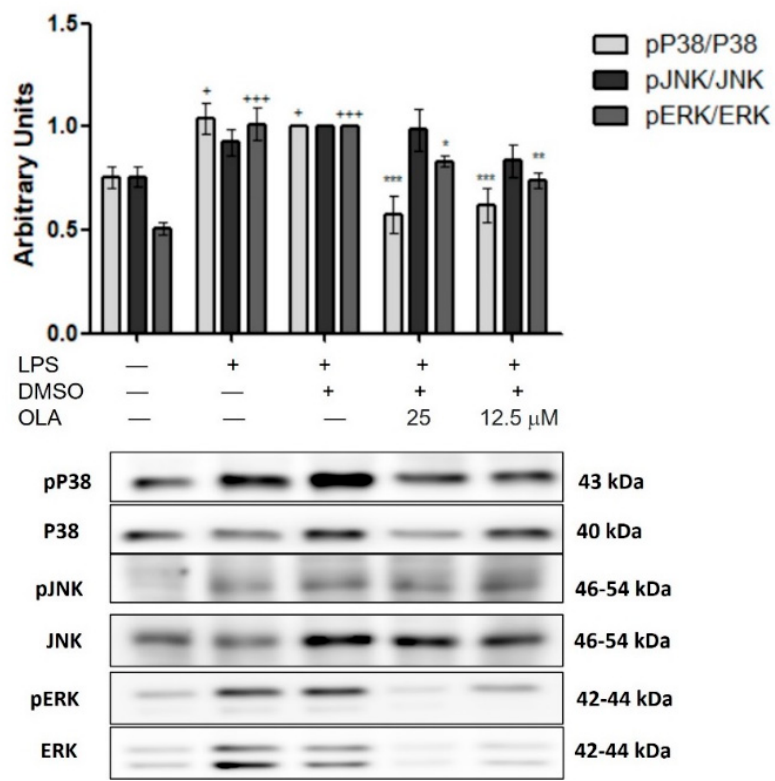
Figure 6. Effects of OLA on MAPKs activation in murine peritoneal macrophages. Cells were pretreated with OLA (25 and 12.5 µ M) for 30 min and then incubated in presence or absence of LPS for 18 h. As controls, cells were also treated with DMSO (solvent control). Densitometry was performed after normalization to the control (P38, JNK, ERK housekeeping gene). Results are represented as means ± SEM ( n = 6). + p < 0.05, +++ p < 0.001 vs. control cells (no stimulated); * p < 0.05, ** p < 0.01, *** p < 0.001 vs. LPS − DMSO-treated cells.